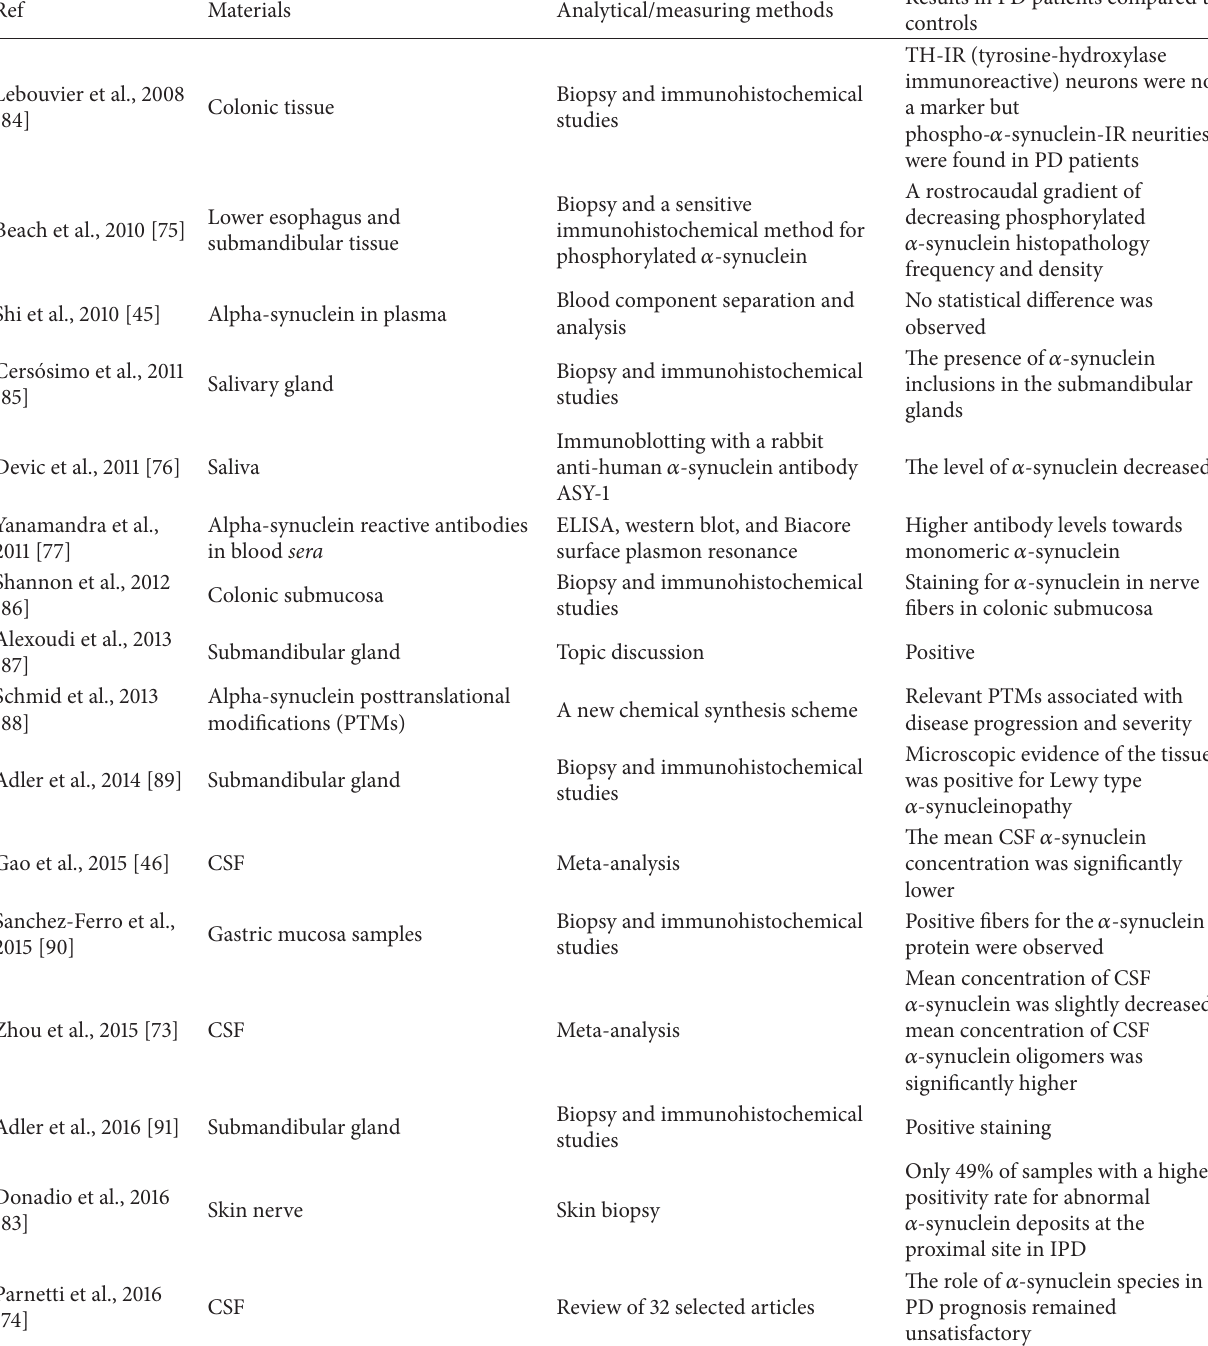
Table 1: Selected studies targeting 𝛼 -synuclein as biomarker for the diagnosis of